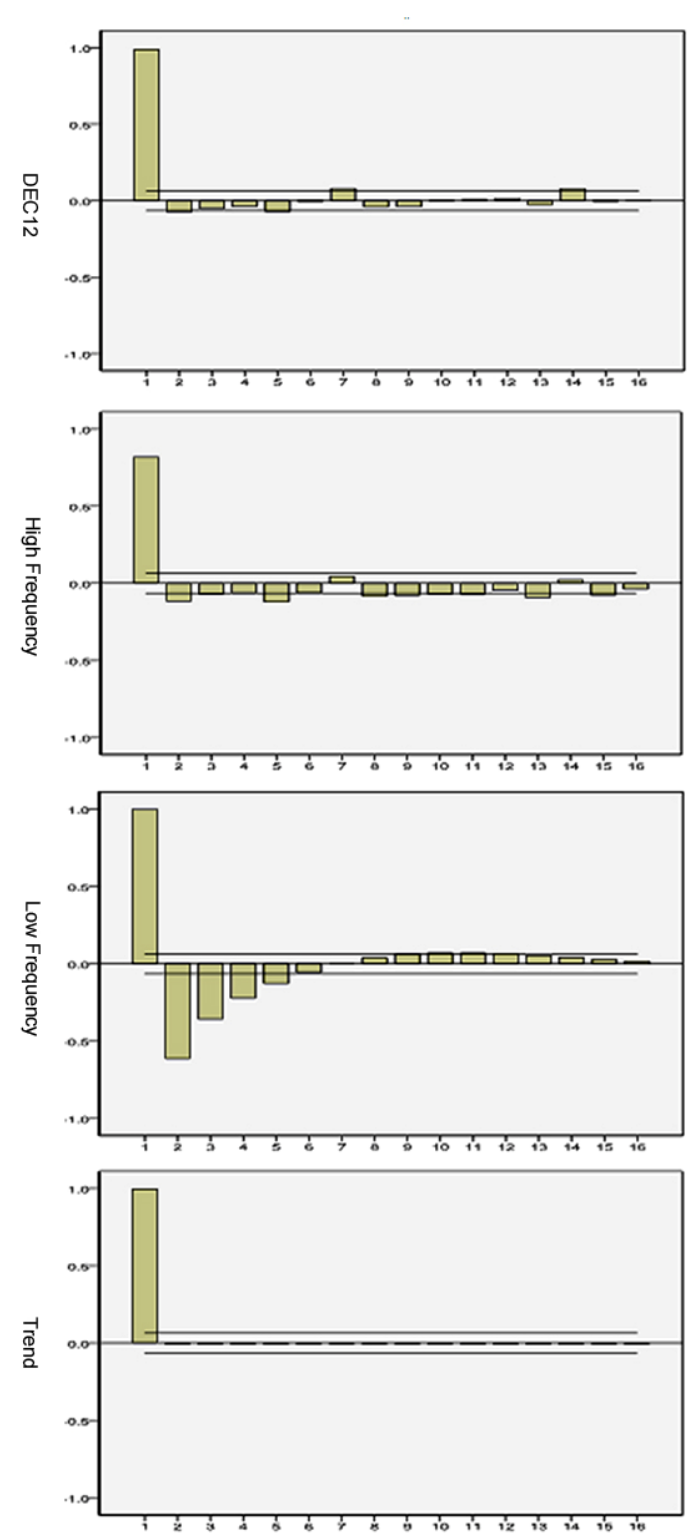
Figure 9. The PACFs of the original series and the reconstructed components of